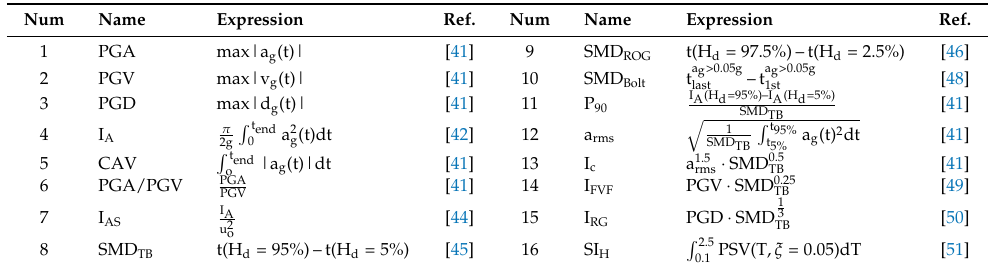
Table 1. Mathematical expressions of